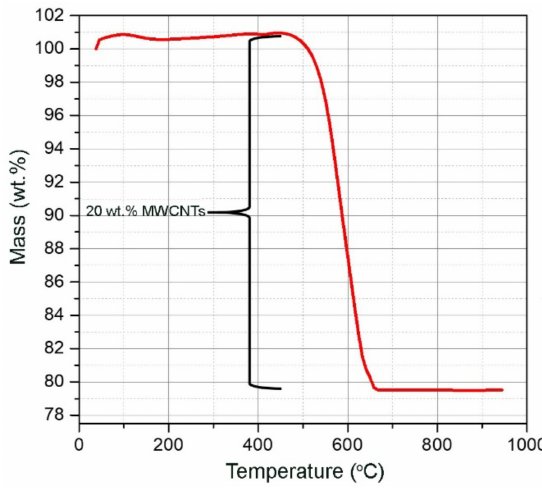
Figure 4. TGA curve of the thermal decomposition of SiO 2